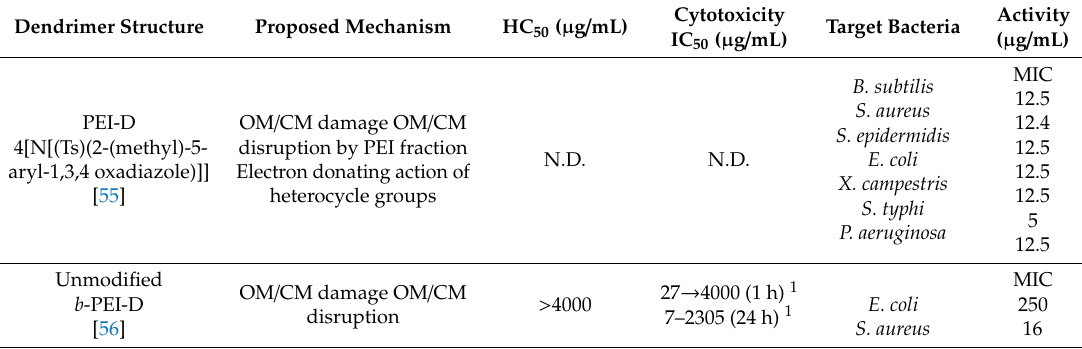
Table 6. Most representative antimicrobial PEI-Ds developed in the years 2010–2020 and antibacterial activity of the most e ff ective ones among the series